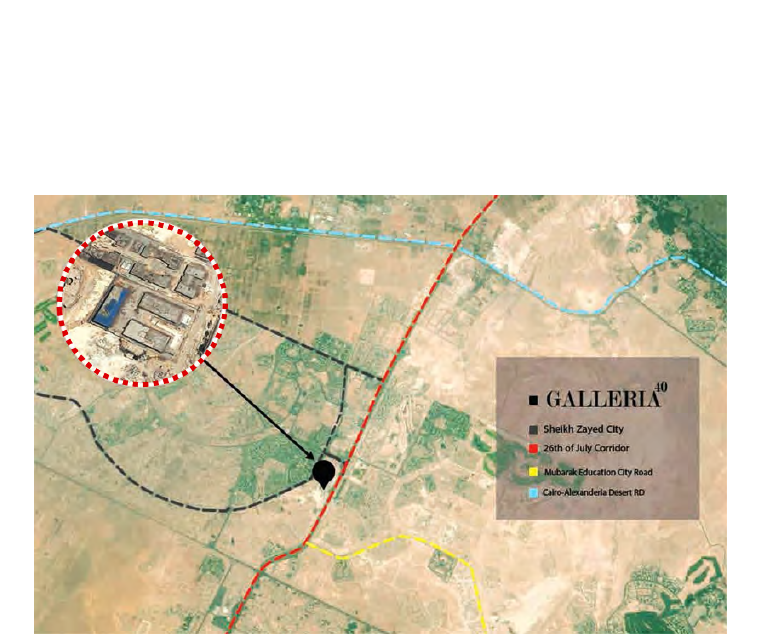
Figure 4. A map showing the study area and the case studyRaya Plaza Building (Beckman, 2017)